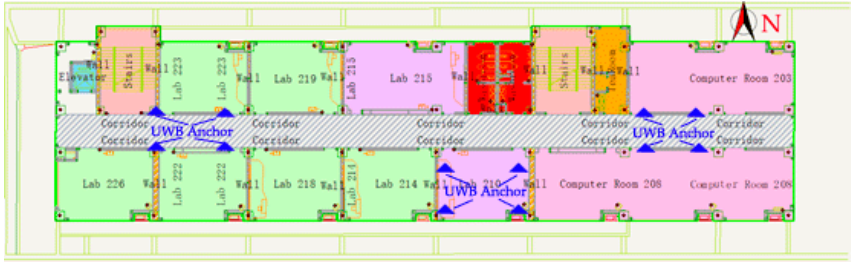
Figure 6. Floor Map of the experiment environment.